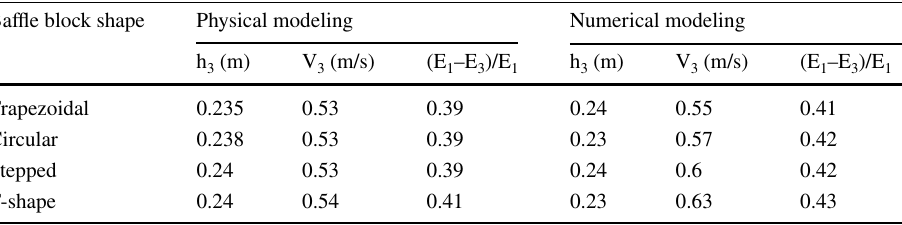
Table 4 Energy-dissipating rates obtained by numerical modeling for the single-row energy-dissipating block at maximum design discharge of Q = 39.6